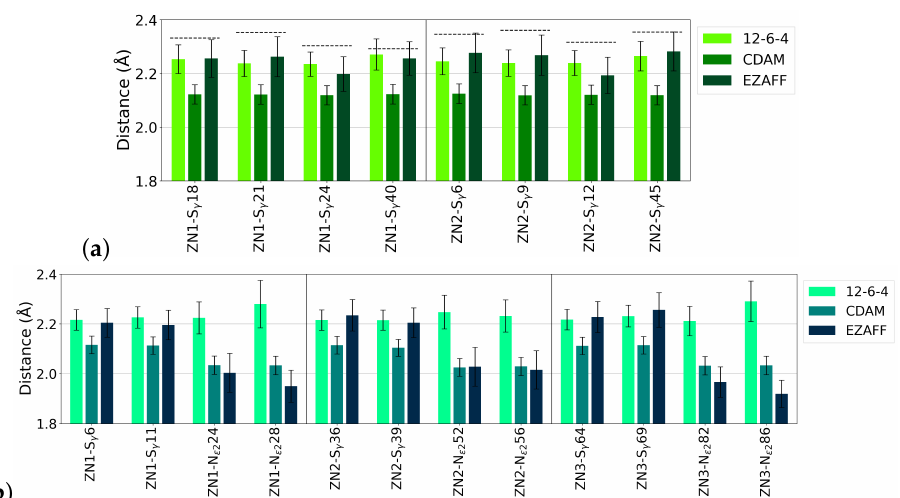
Figure 7. Distance between the Zn 2 + -ions and their coordinating atoms (residue indices given; for corresponding residue names, see Table S1) in ( a ) MLL1 and ( b ) WT1. The error is given as the standard deviation. Crystal structure values are indicated as black dashed lines.